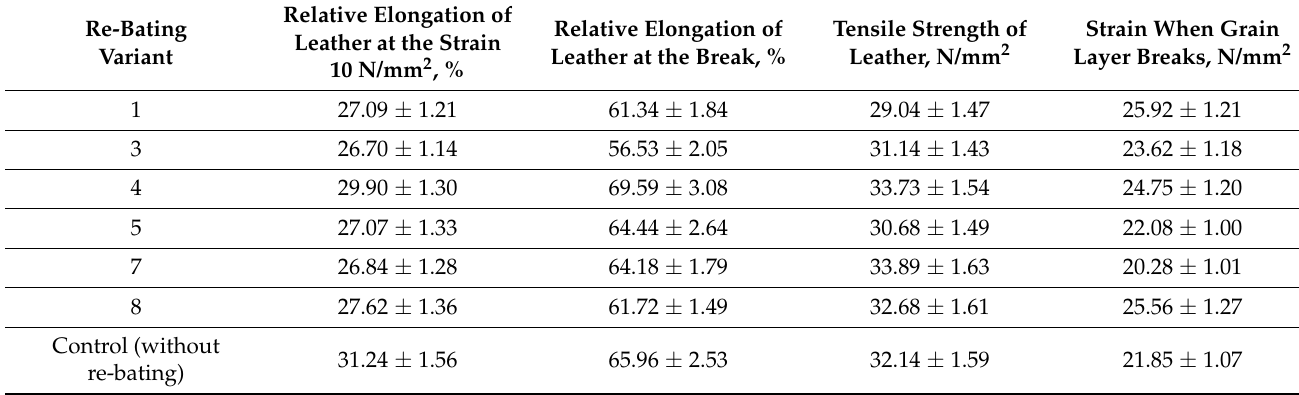
Table 7. Physical and mechanical properties after post-tanning